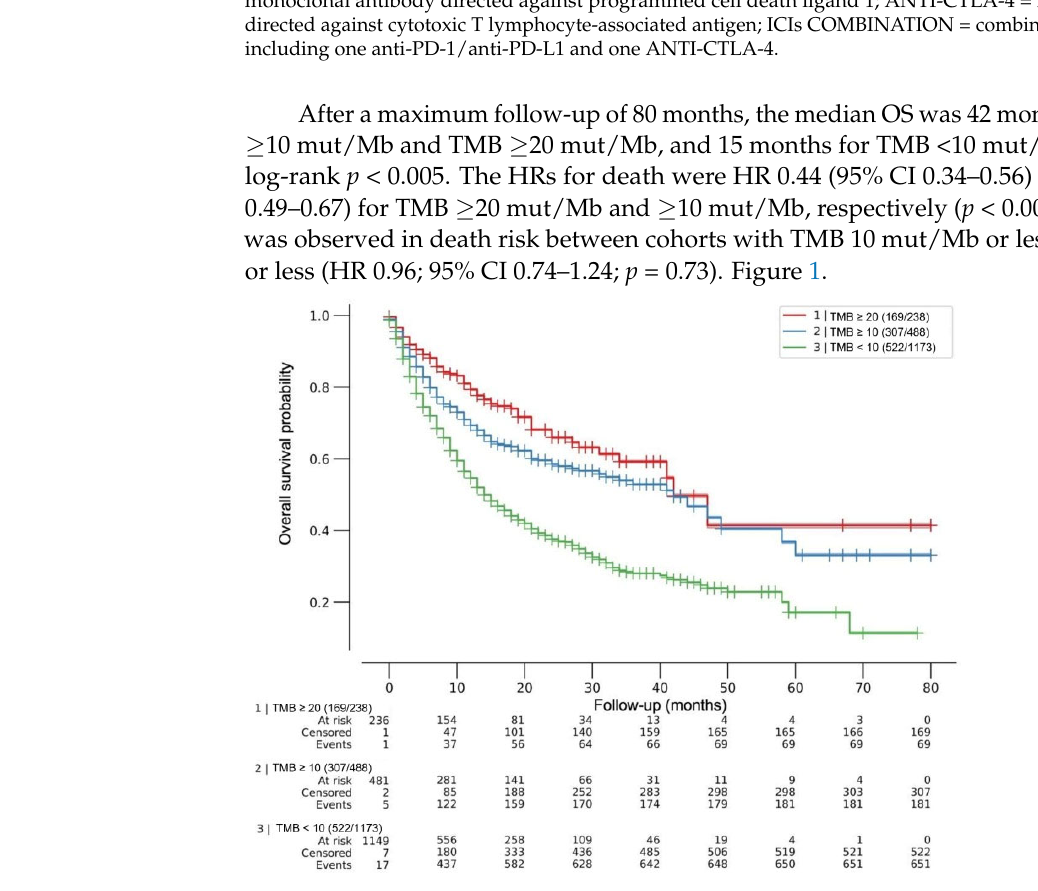
Figure 1. Effect of tumor mutational burden (TMB) on overall survival after ICI treatment. Kaplan–Meier (KM) curves for patients with tumors within each TMB predefined cutoff. Overall survival was from the first dose of ICIs. Median OS was 42 months for both TMB ≥ 20mut/Mb and TMB ≥ 10 mut/Mb, and 15 months for TMB < 10 mut/Mb, multivariate log-rank p < 0.005. Cox regression HRs for death were 0.44 (95% CI 0.34–0.56) and 0.57 (95% CI 0.49–0.67) for TMB ≥ 20 mut/Mb and ≥ 10 mut/Mb, respectively ( p < 0.005). No difference was observed in death risk between cohorts with TMB 10 mut/Mb or less and 1 mut/Mb or less (HR 0.96; 95% CI 0.74–1.24; p = 0.73). ICIs = immune checkpoint